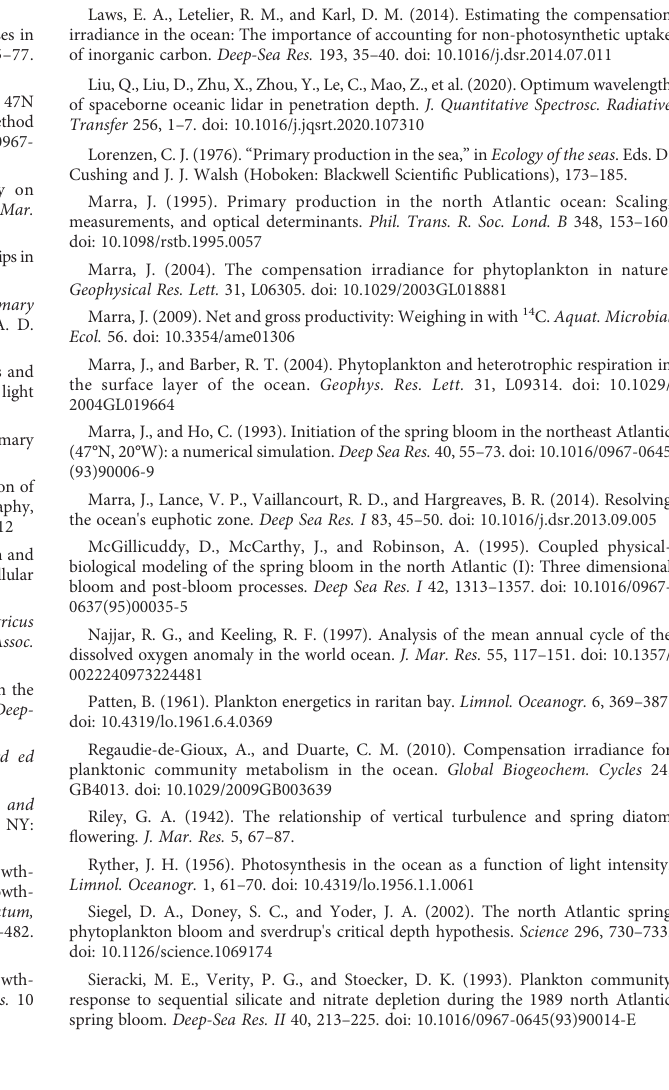
SUPPLEMENTARY FIGURE 1 Example relative fl uorescence pro fi le from 30 April. The base of the fl uorescence maximum was estimated to be the intersection of two regression lines, one from the fl uorescence maximum to an in fl ection point, and the other from the bottom of the pro fi le to the in fl ection